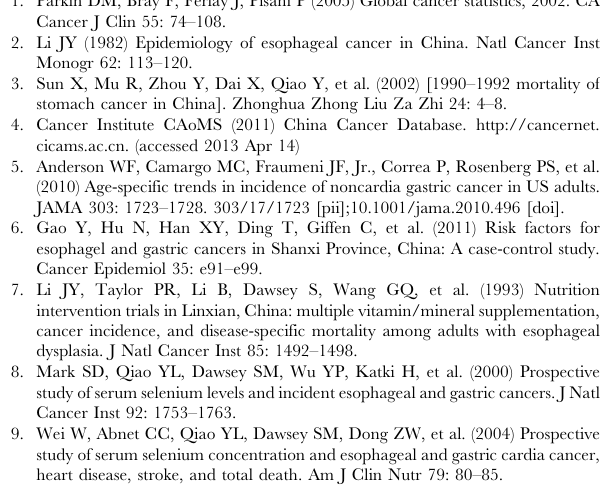
Table S1 Clinical characteristics of cases ( Table S1a : Clinical characteristics of GCA cases (N= 62); Table S1b : Clinical characteristics of GNCA cases (N= 72). Table S2 Summary of 239 genes that are significantly differentially expressed in both GCA and GNCA.